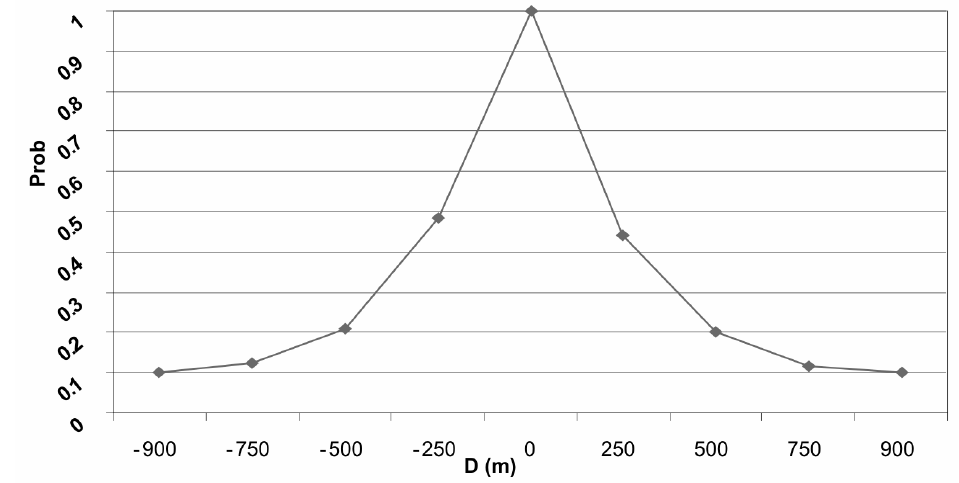
Fig 2. A probability graph for walking to origin